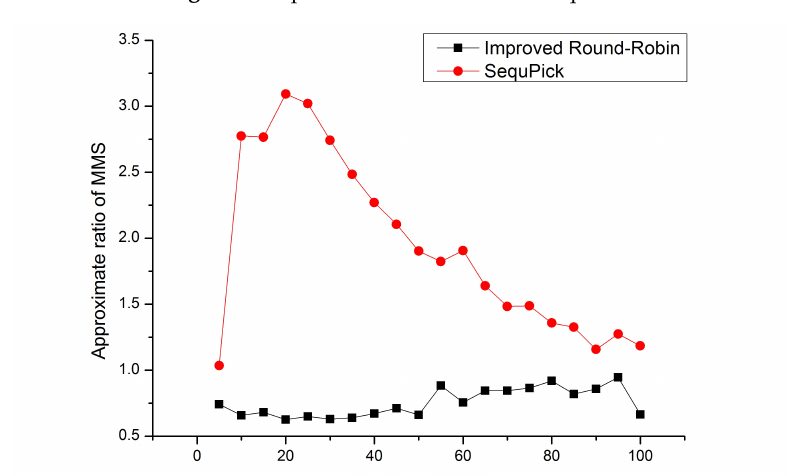
Figure 4. Improved Round-Robin vs. SequPick.